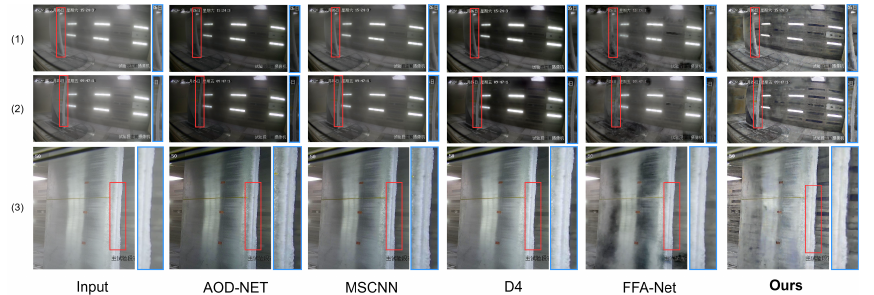
Figure 9. A partial comparison of our model with a deep learning-based dehazing algorithm. The blue box area is an enlarged version of the red box area in ( 1 , 2 ) LWC = 1.0; and ( 3 ) LWC =